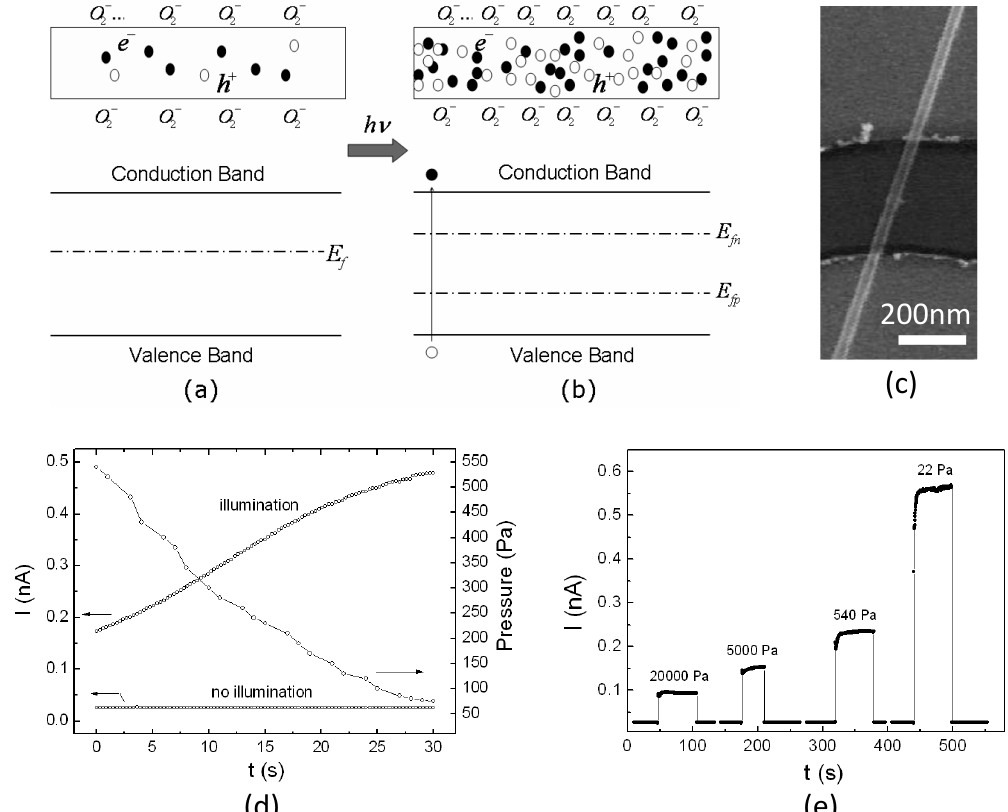
Figure 10. Optically driven oxygen sensing in β-Ga O nanowires. Schematic and 2 3 energy-level representations of the nanowires ( a ) without and ( b ) under ultraviolet is the Fermi level, E and E are the steady-state Fermi level for electrons illumination, E f fn fp and holes under the illumination, respectively. ( c ) A SEM image of the nanowire oxygen sensors. ( d ) The current of the device as the oxygen pressure in the chamber changes. The illumination makes the devices become sensitive to oxygen. ( e ) Current-time curves under different oxygen pressures, very fast response and recovery processes can be realized. Reprinted from reference [93] with permission from AIP